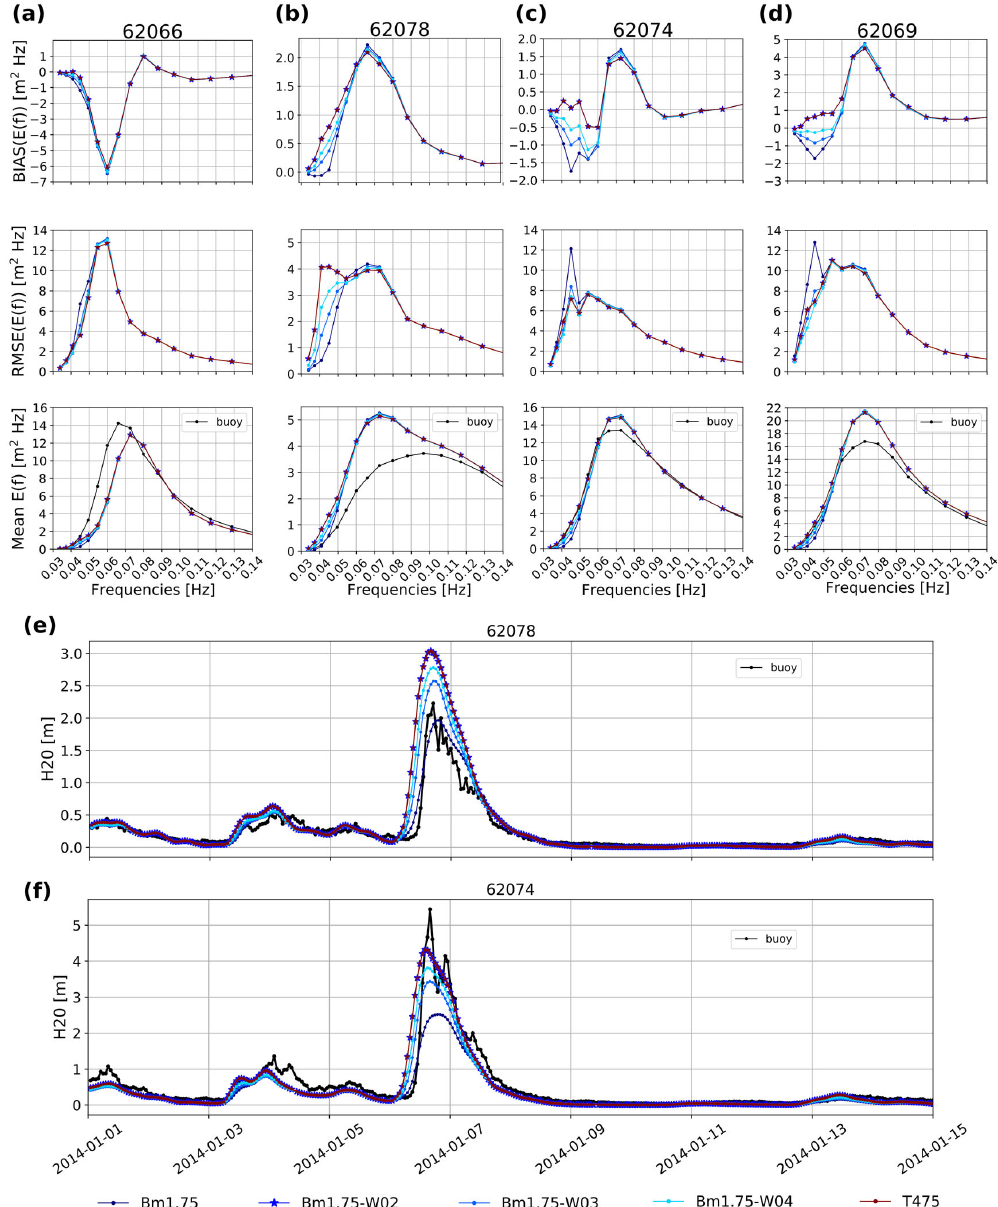
Figure 7. Performance parameters for energy levels at each discrete frequency of the spectrum, for tests leading to T475 (Table 2). Results for January 2014 at buoys 62066, 62078, 62074, and 62069. In panels (a–d) 1-month modeled results compared with buoy data. Time